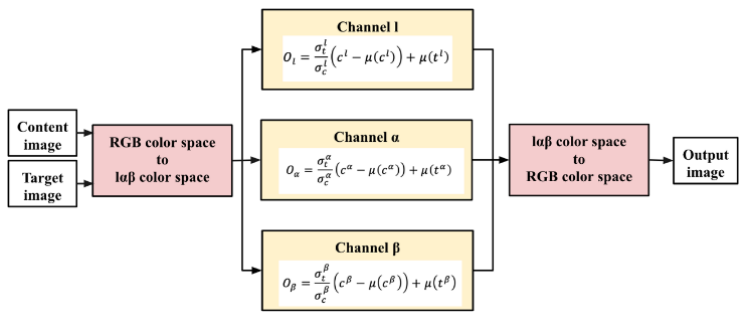
Figure 1. The architecture of Reinhard et al.’s method.